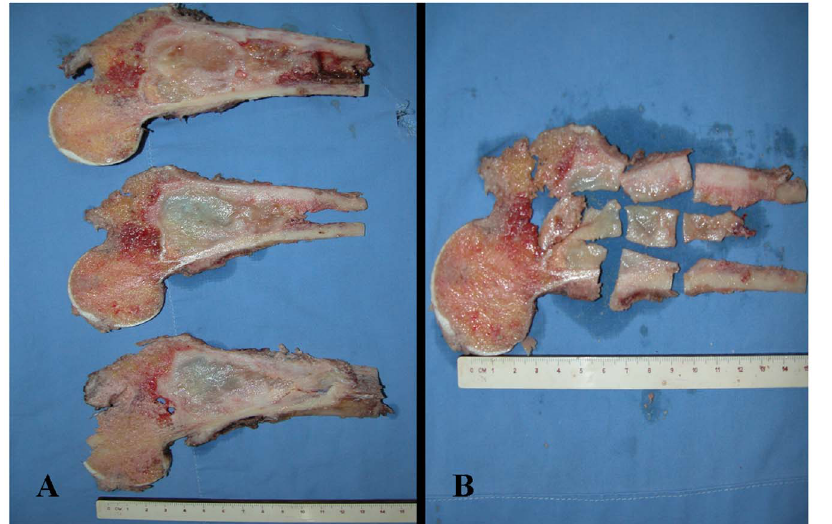
Figure 1. Tissue processing of the resected specimen. ( A ) Samples were collected from the center of the resected tumor. ( B ) After dividing the tissue into small pieces, all small pieces of tissues were embedded and numbered. Necrosis rate was determined.